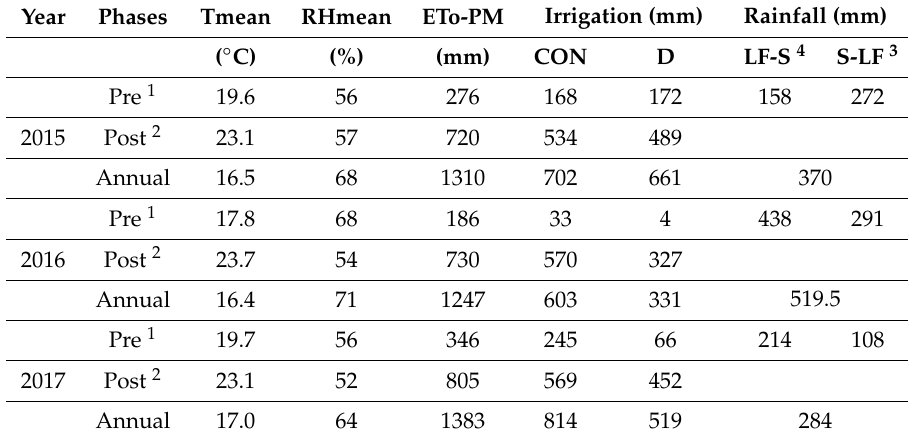
Table 2. Mean temperature (Tmean), mean relative humidity (RHmean), accumulated rainfall, accumulated evapotranspiration (ETo) and irrigation applied in pre- and post-harvest periods and